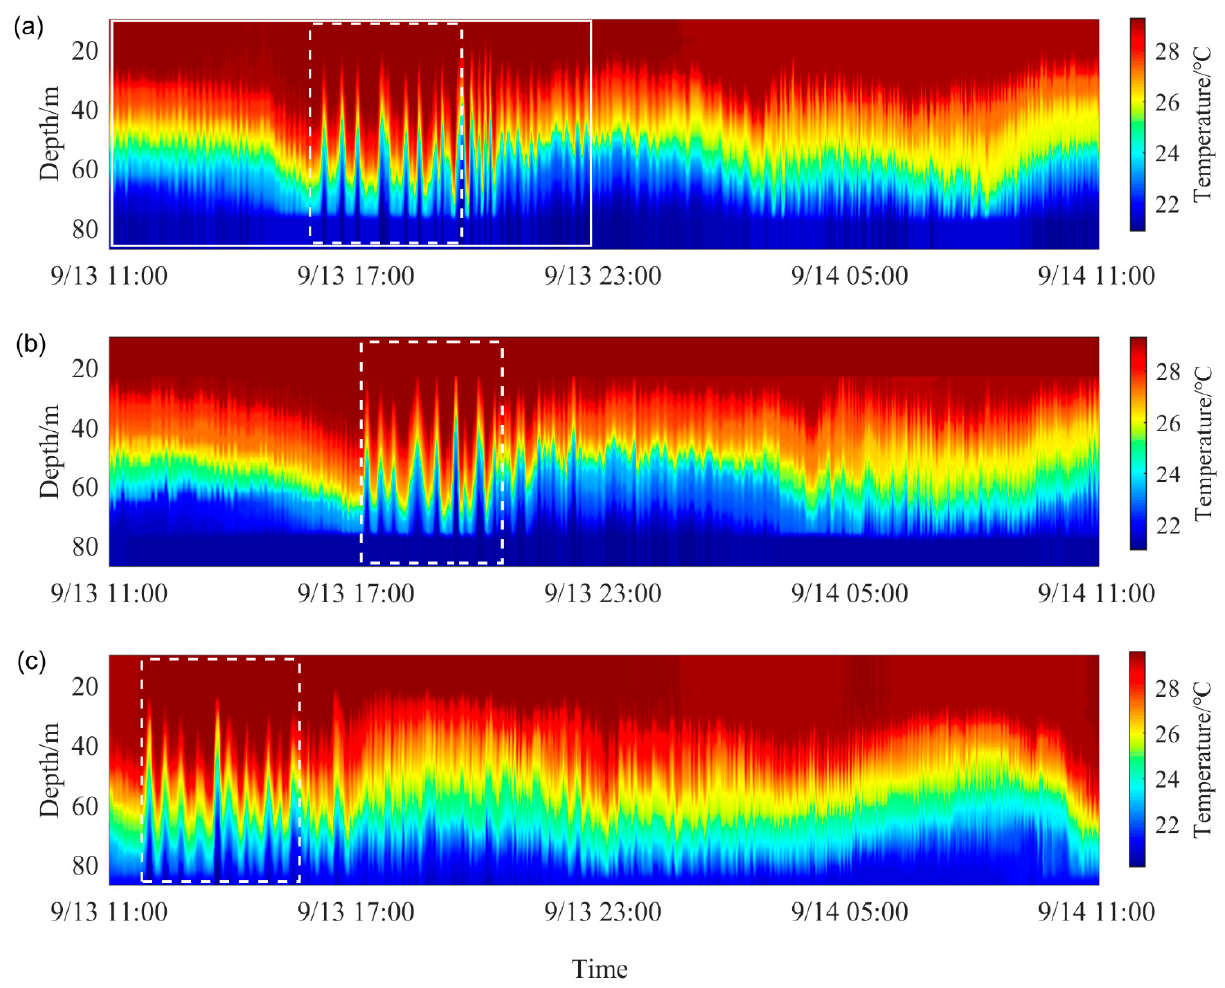
Figure 3. The whole temperature profiles from 13 September, 11:00 to 14 September, 11:00 (GTM), recorded every 30 s. The data in the white dotted box is the test set, and the rest of the data in the white solid box is the training set. ( a ) H1, ( b ) O1, ( c ) S17.